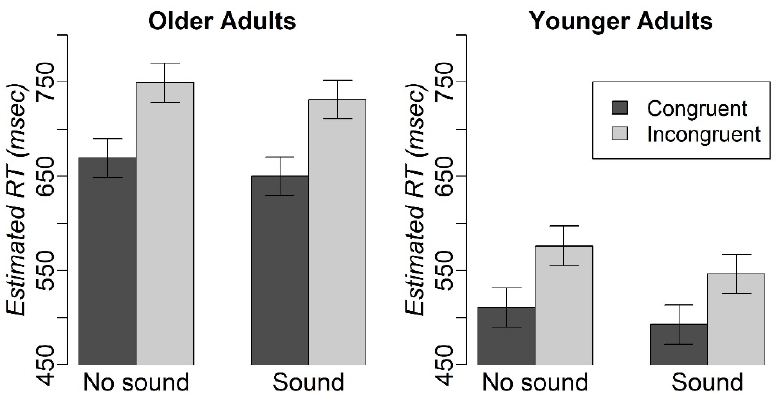
Figure 2. RT on accurate trials in the modified Simon task in older and younger adults. Mean RT and Accuracy in the modified Simon task. Table 2. Model estimated RT and accuracy in the modified Simon task.